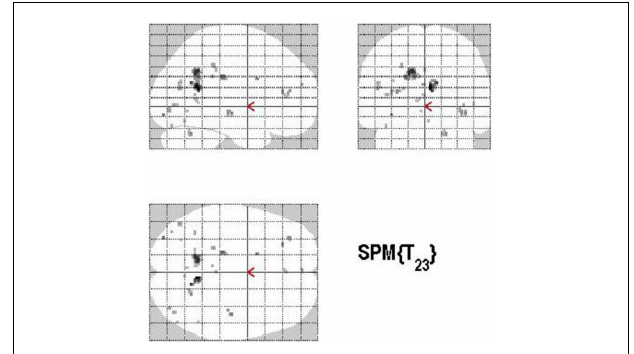
FIGURE 7 | Group activations for the contrast between MONITORING versus RETRIEVAL. Activations are superimposed on the anatomical group mean image (see Materials and Methods), depicting statistically significant relative increases in neural activity at p < 0.001, uncorrected. See Table 4 for the exact MNI